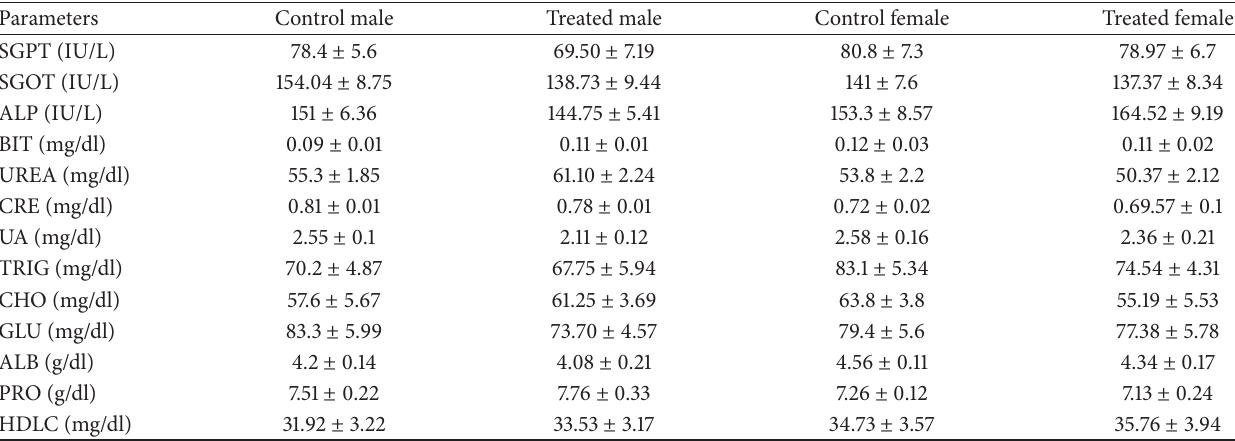
Table 4: Biochemical parameters of male and female rats.